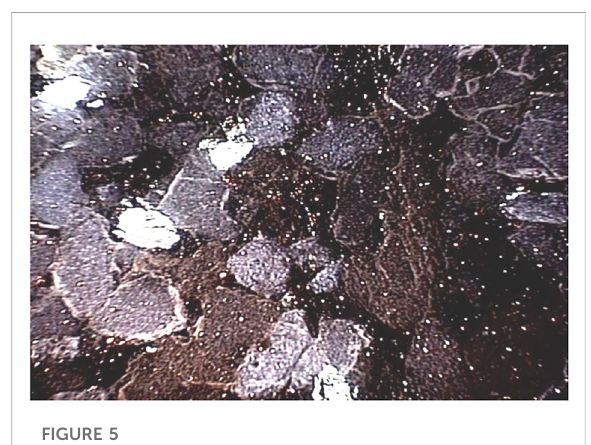
FIGURE 5 Test results through cathode